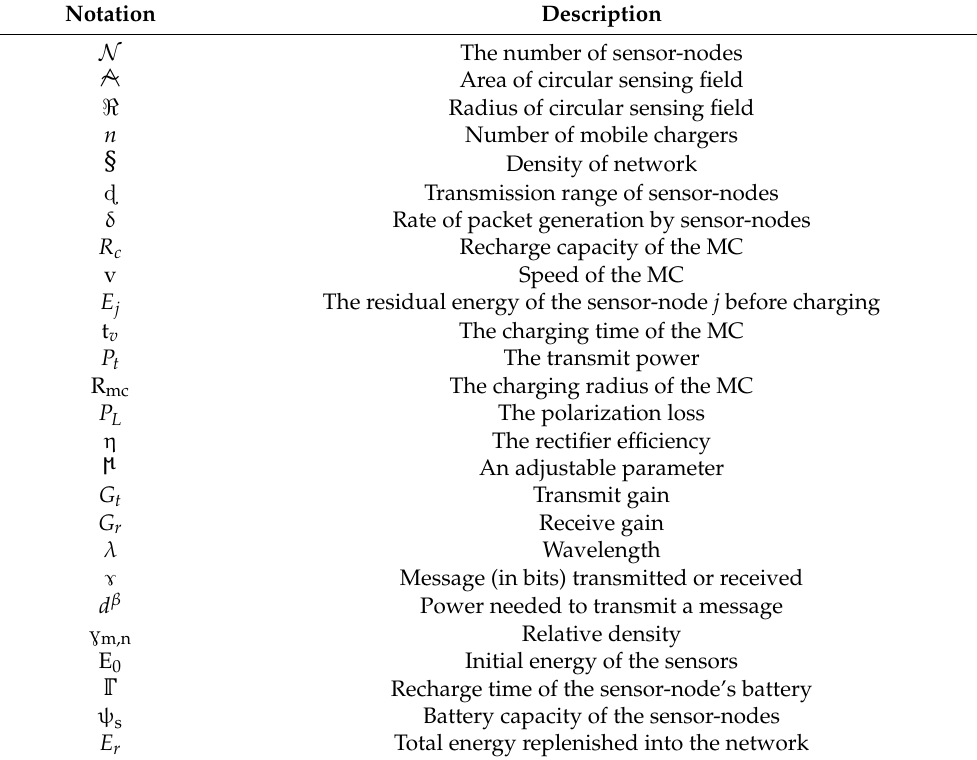
Table 1. Notations with their descriptions.